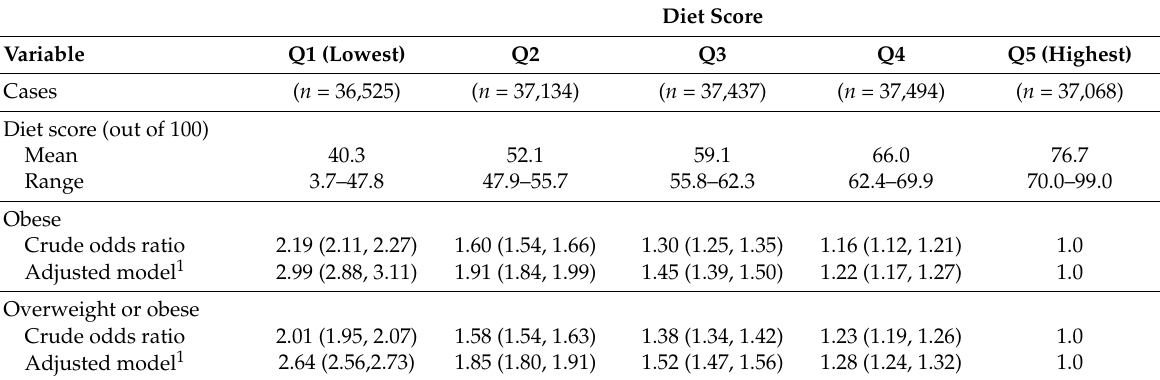
Table 2. Multinomial adjusted odds ratios and 95% confidence internals of overweight and obese per quintile of Diet Score 1